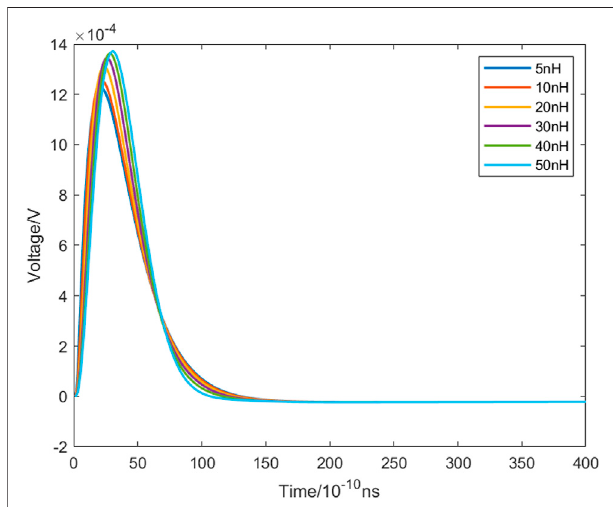
FIGURE 15 | Effect of L s on sensor detection